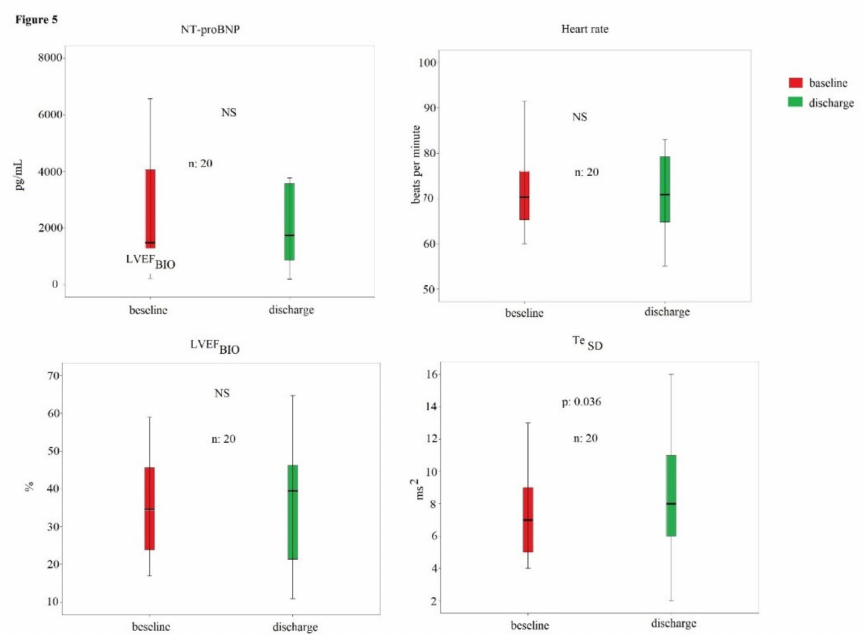
Figure 5. NT-proBNP, heart rate, LVEFBIO, and TeSD in nonresponder patients to the optimal medical therapy.